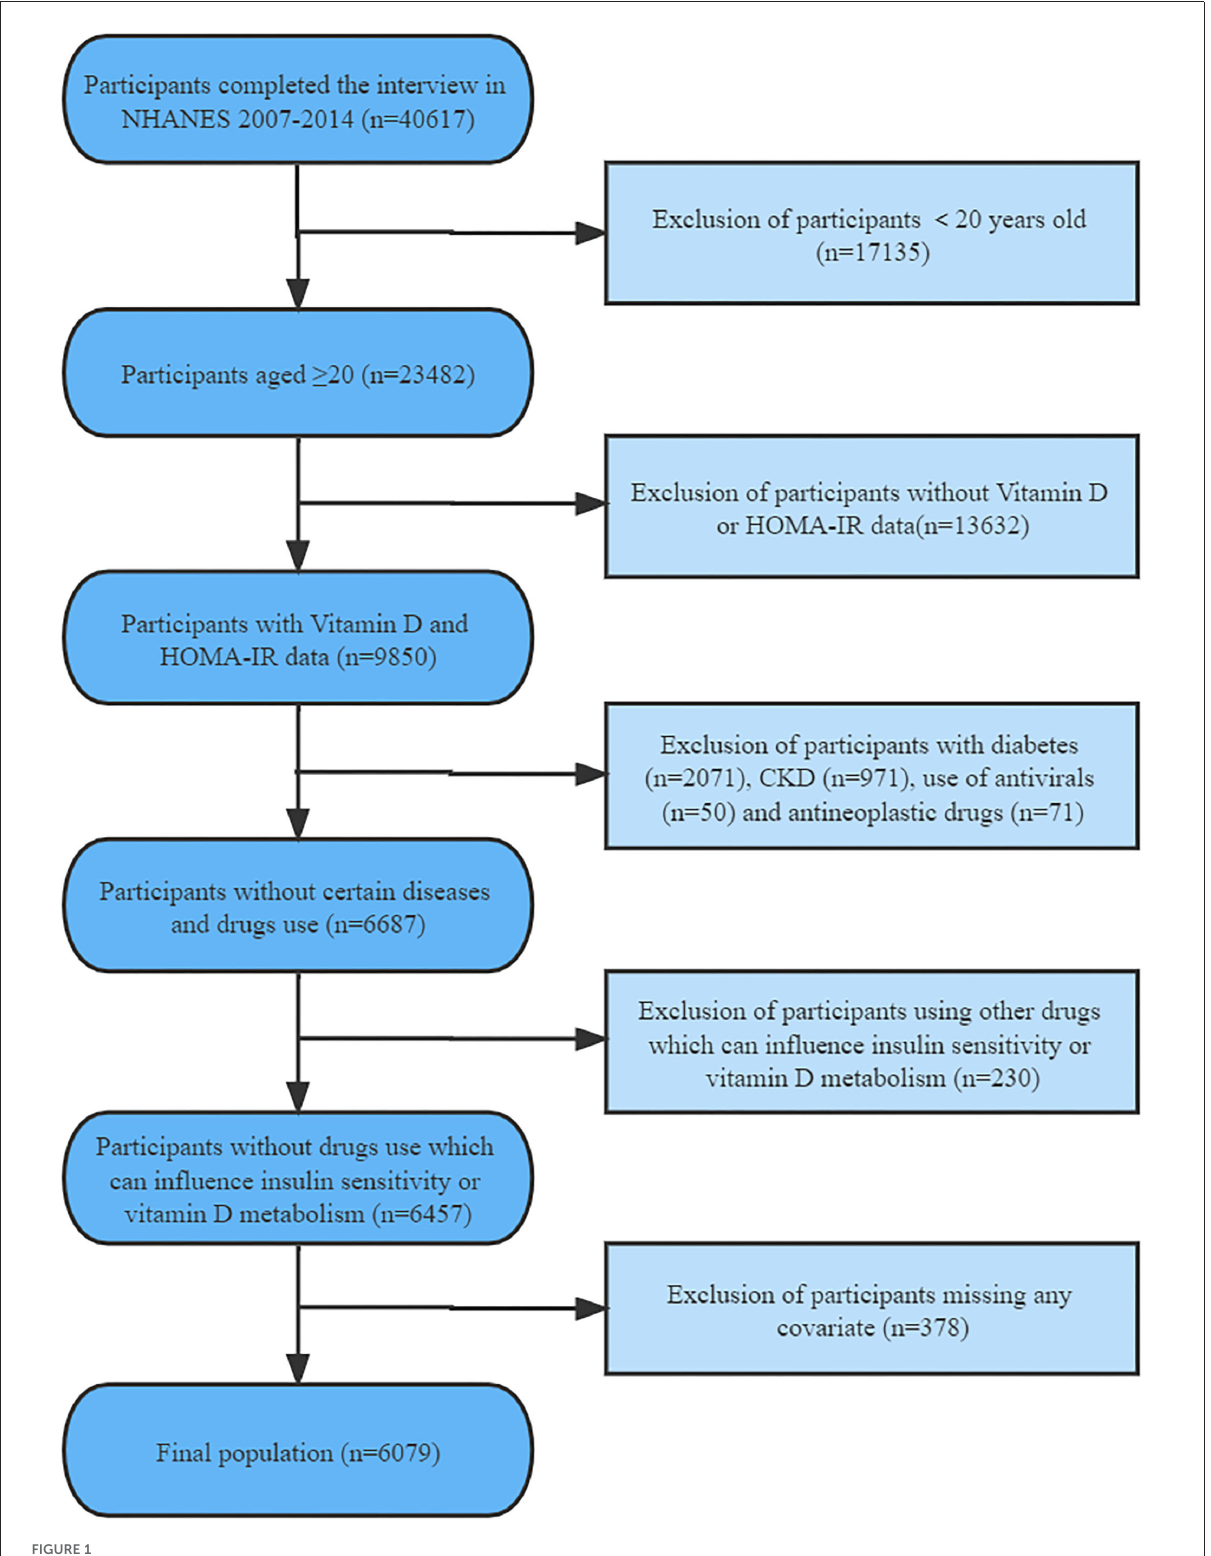
FIGURE1 Flowchart of participants’